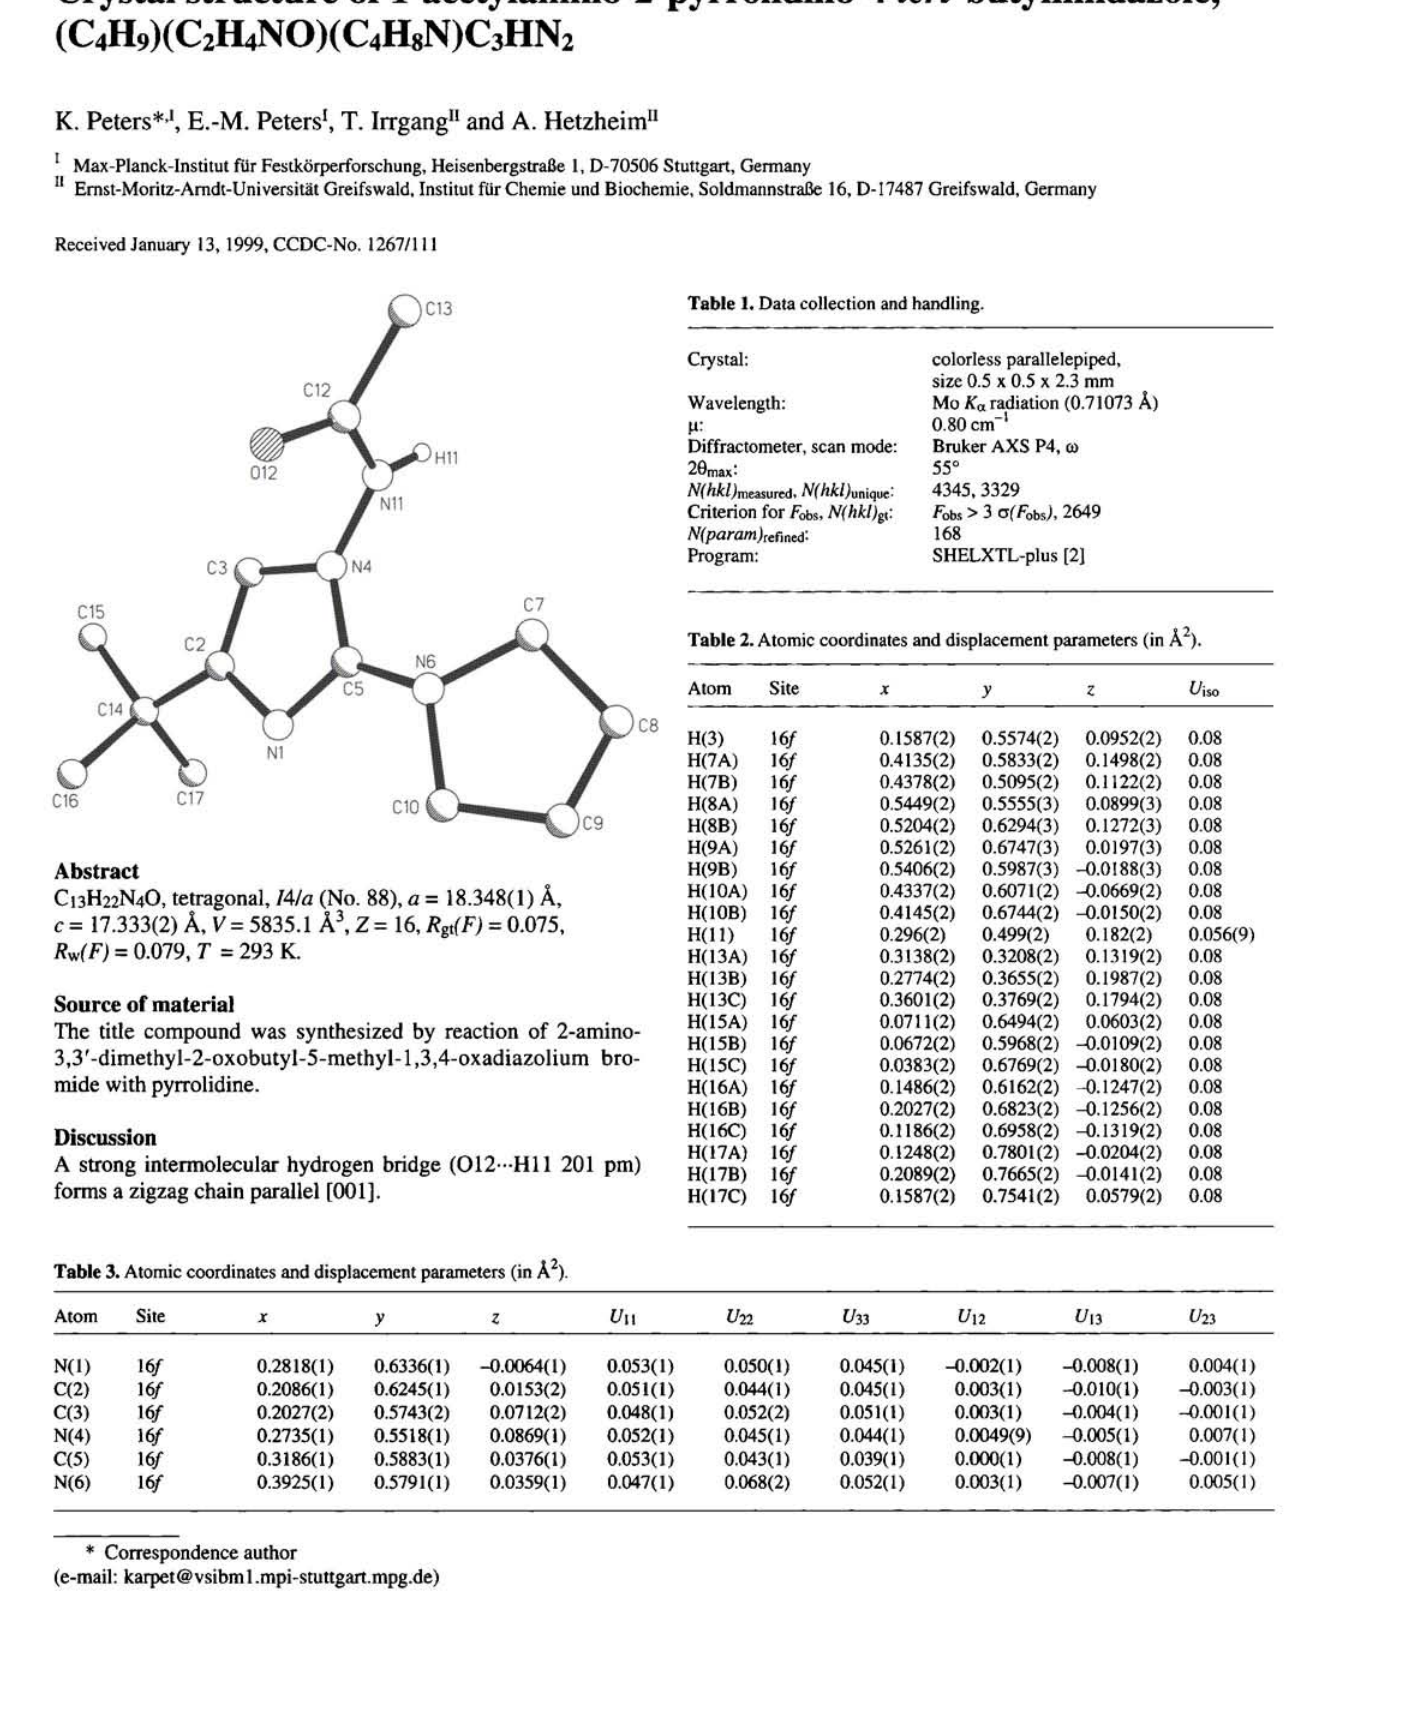
Table 3. Atomic coordinates and displacement parameters (in Â 2